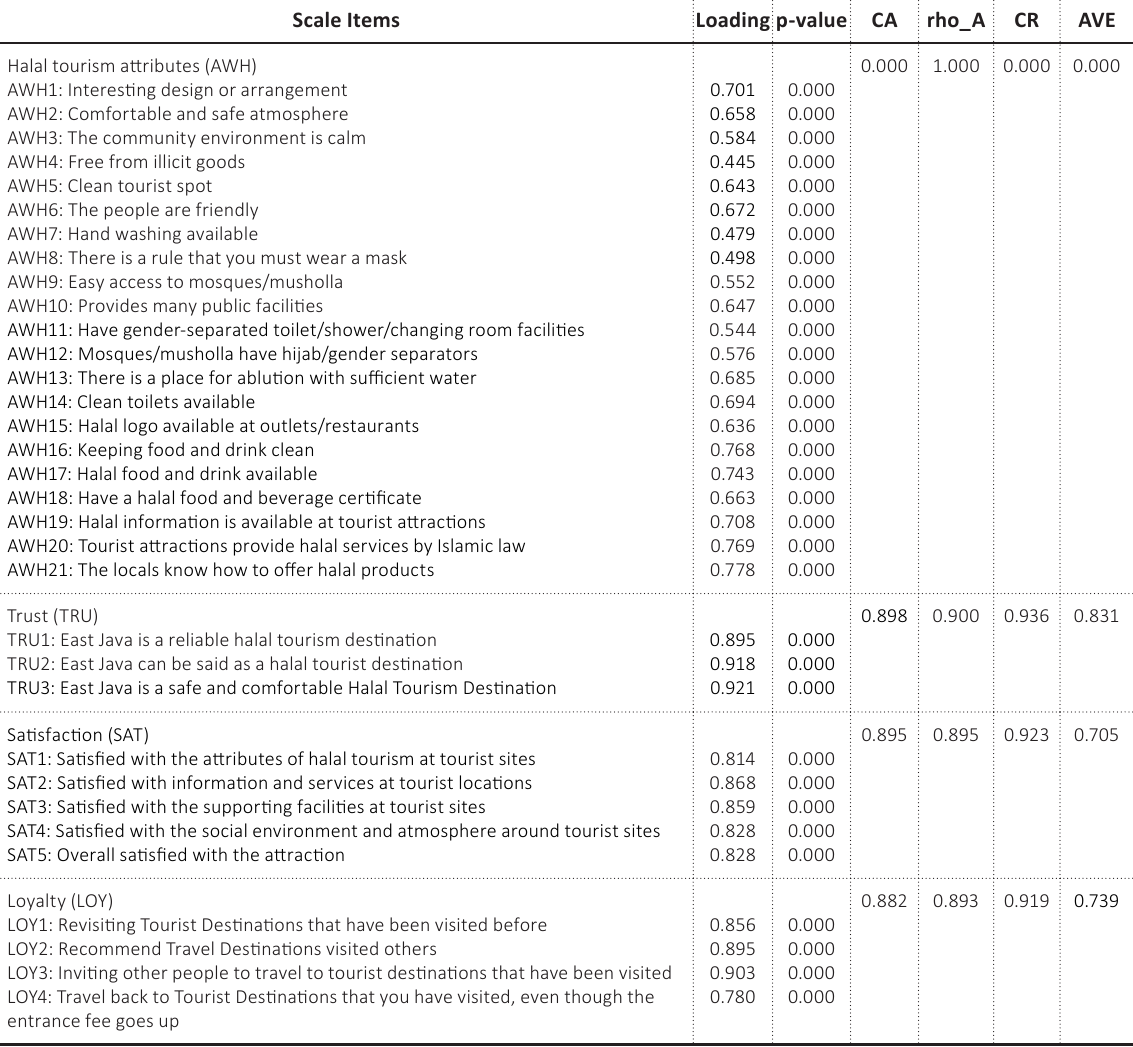
Table 2. Construct reliability and validity